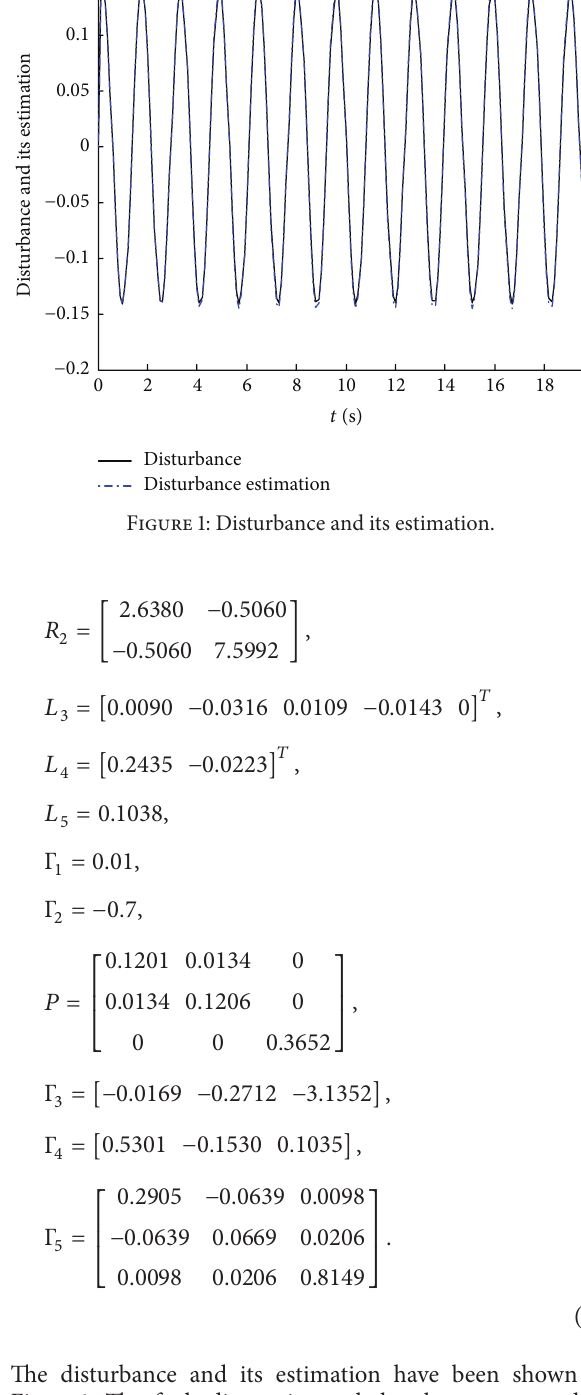
The disturbance and its estimation have been shown in Figure 1. The fault diagnosis result has been presented in Figure 2. It can be seen that the desired fault diagnosis result has been obtained and the influence of disturbance has been rejected. The initial PDF, the desired PDF, and the final PDF with fault tolerant control are given in Figure 3. In Figures 4 and 5, the three-dimensional mesh plot shows the changes of the output PDF without and with fault tolerant control, respectively. Before fault occurs, the fault tolerant controller has not been reconstructed, so the disturbance cannot